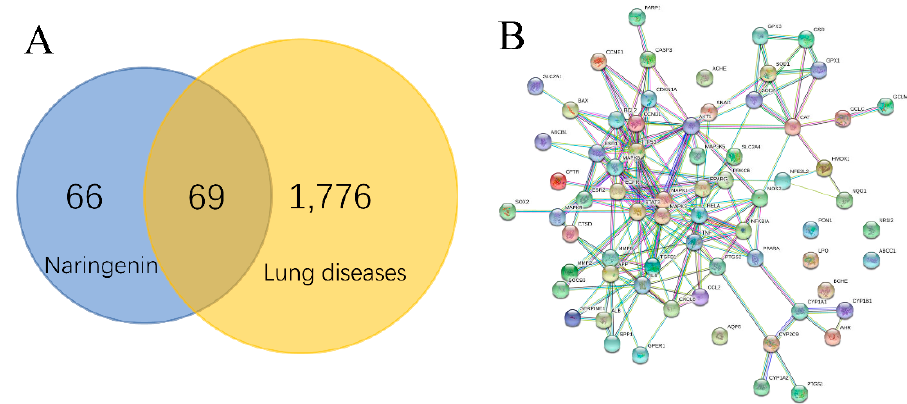
Figure 1. Interaction targets of naringenin and lung diseases in Venn diagram ( A ). PPI network of interaction targets for naringenin-treated lung diseases ( B ).